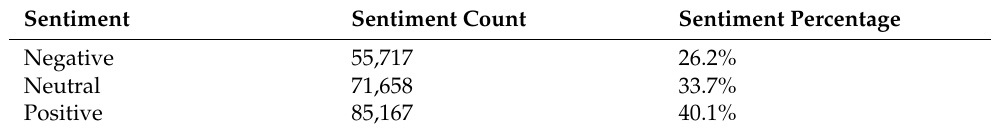
Table 2. Sentiment count.